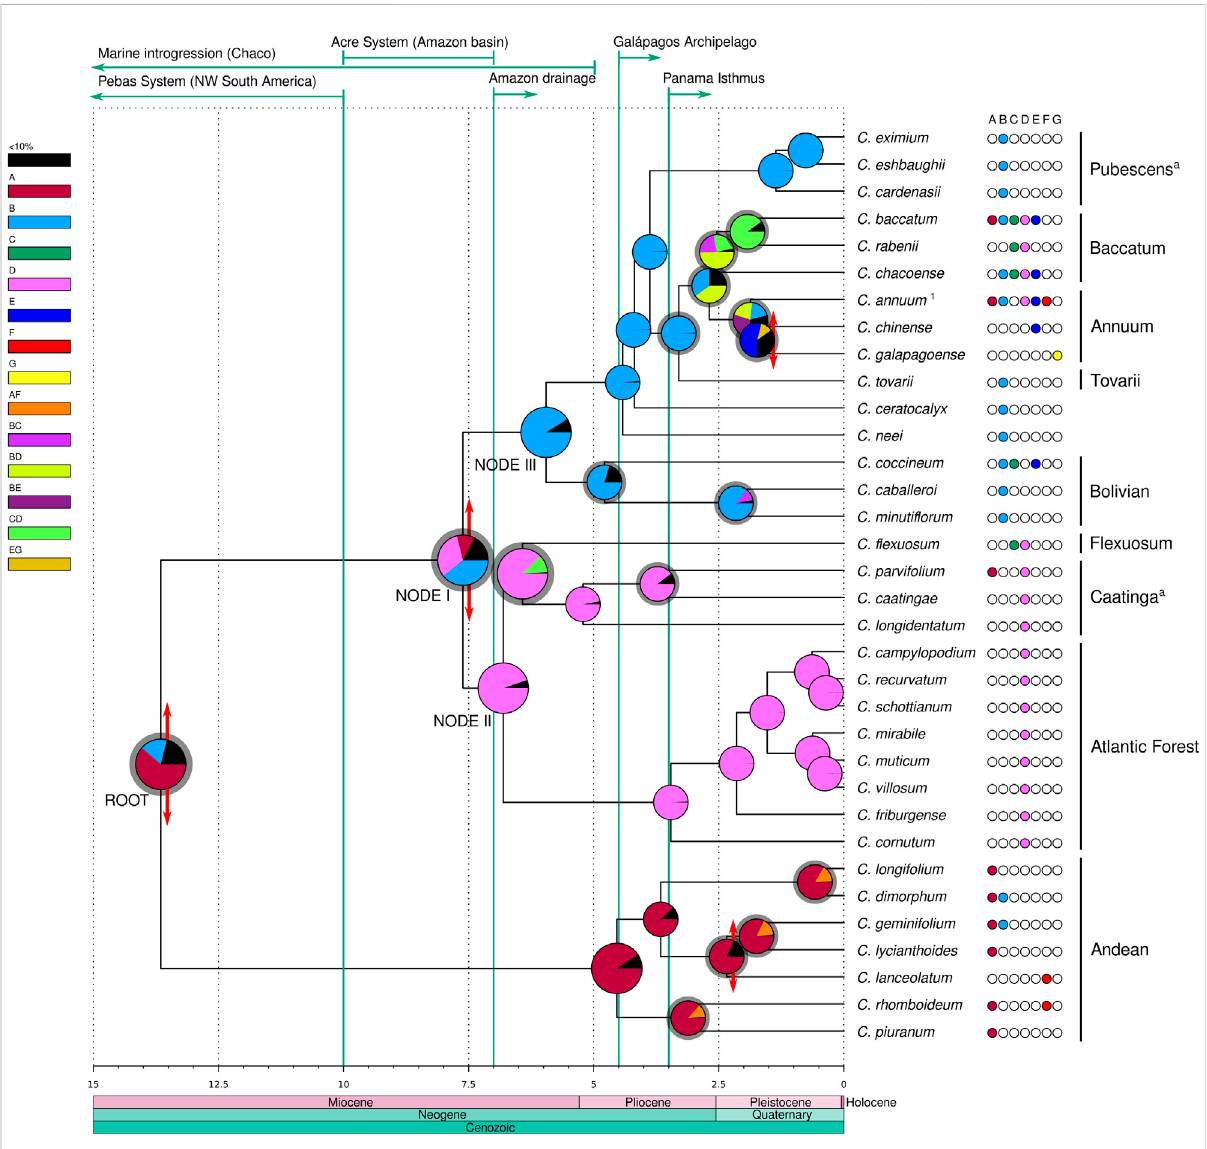
FIGURE 3 Divergence time and ancestral areas estimated within Capsicum . Domesticated taxa with unknown original range are excluded. Recognized cladesarelabeled; a cladesnewlycircumscribed. 1 Represents C.annuum var. glabriusculum .Agesexpressedinmillionsyearsfrompresent.Double- ended red arrows at nodes represent vicariant events, gray shadings at the node pies indicate dispersal events. Major geological events are detailed above, denoted by green arrows/lines. Areas: A. Northern Andes, B. Central Andes, C. Chaco, D. SE South America, E. Amazon basin, F. Central America and southern United States, G. Galápagos